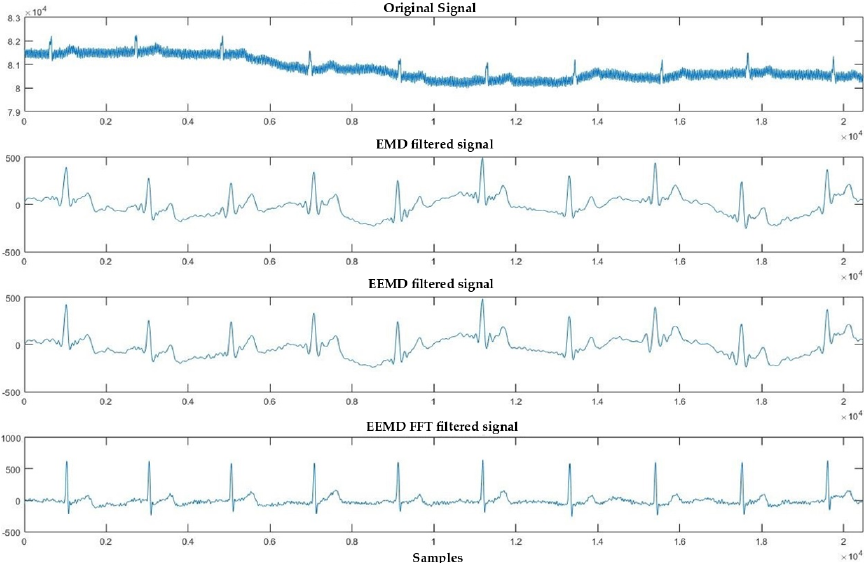
Figure 7. Example of the denoising of an ECG section of upper arm Lead ‐ 1in a clinical case (Patient #1); showing best denoising qualitative performance, ECG waveform, including well ‐ defined P ‐ QRS ‐ T waves.